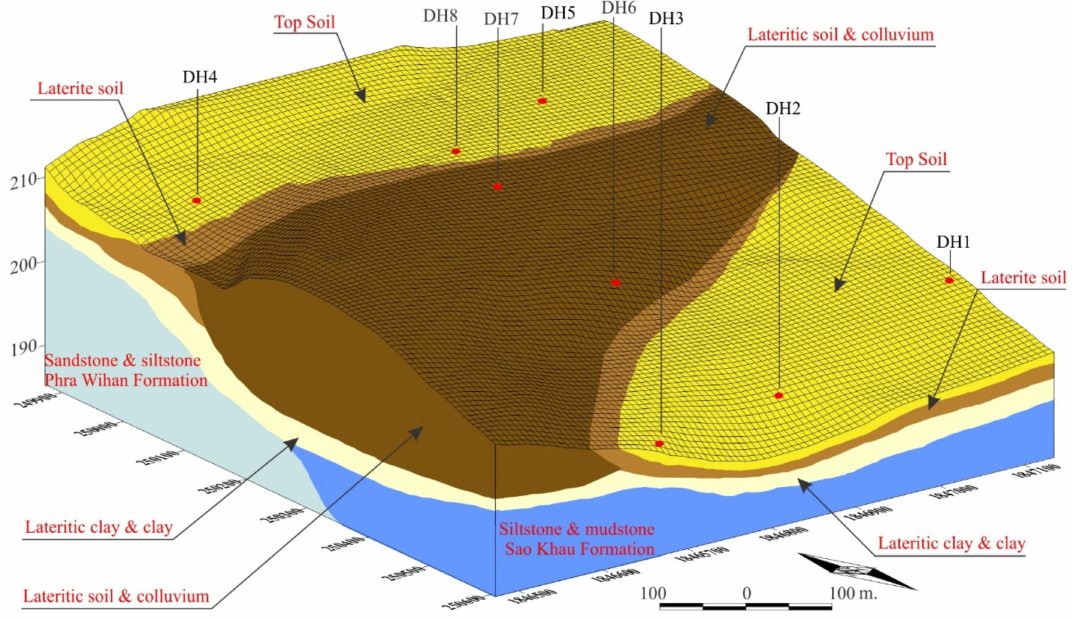
Figure 9. Lithostratigraphic block diagram of subsurface